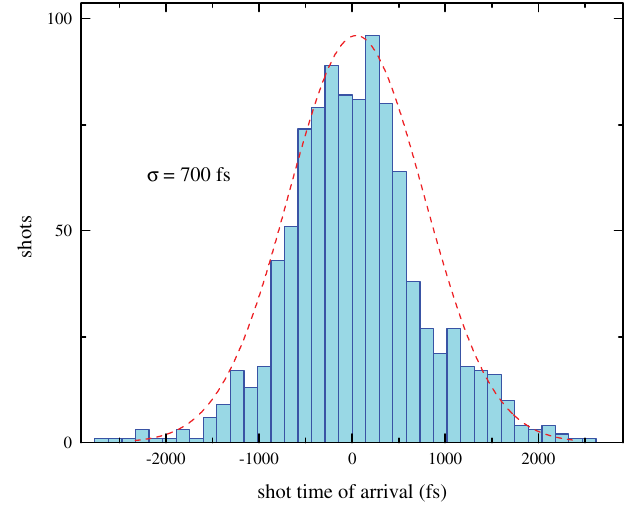
FIG. 7. (Color) Timing jitter